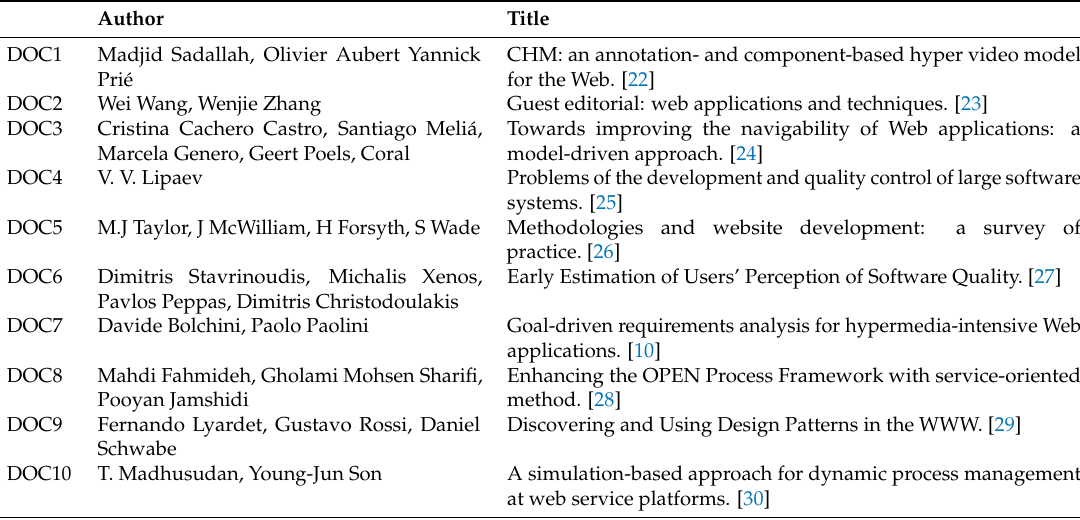
Figure 2. Selection of studies process. Table 4. Related